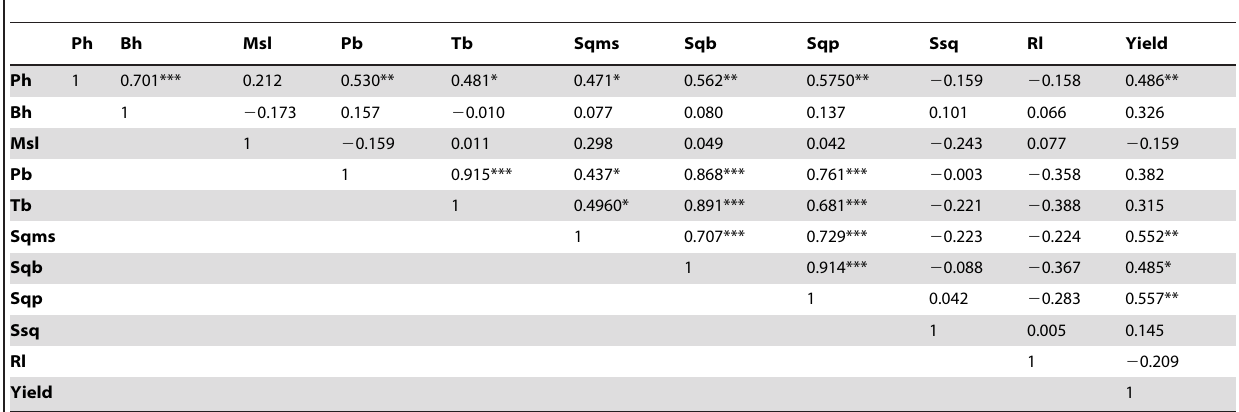
Table 1. Correlation coefficients ( r ) between pairs of yield related traits under